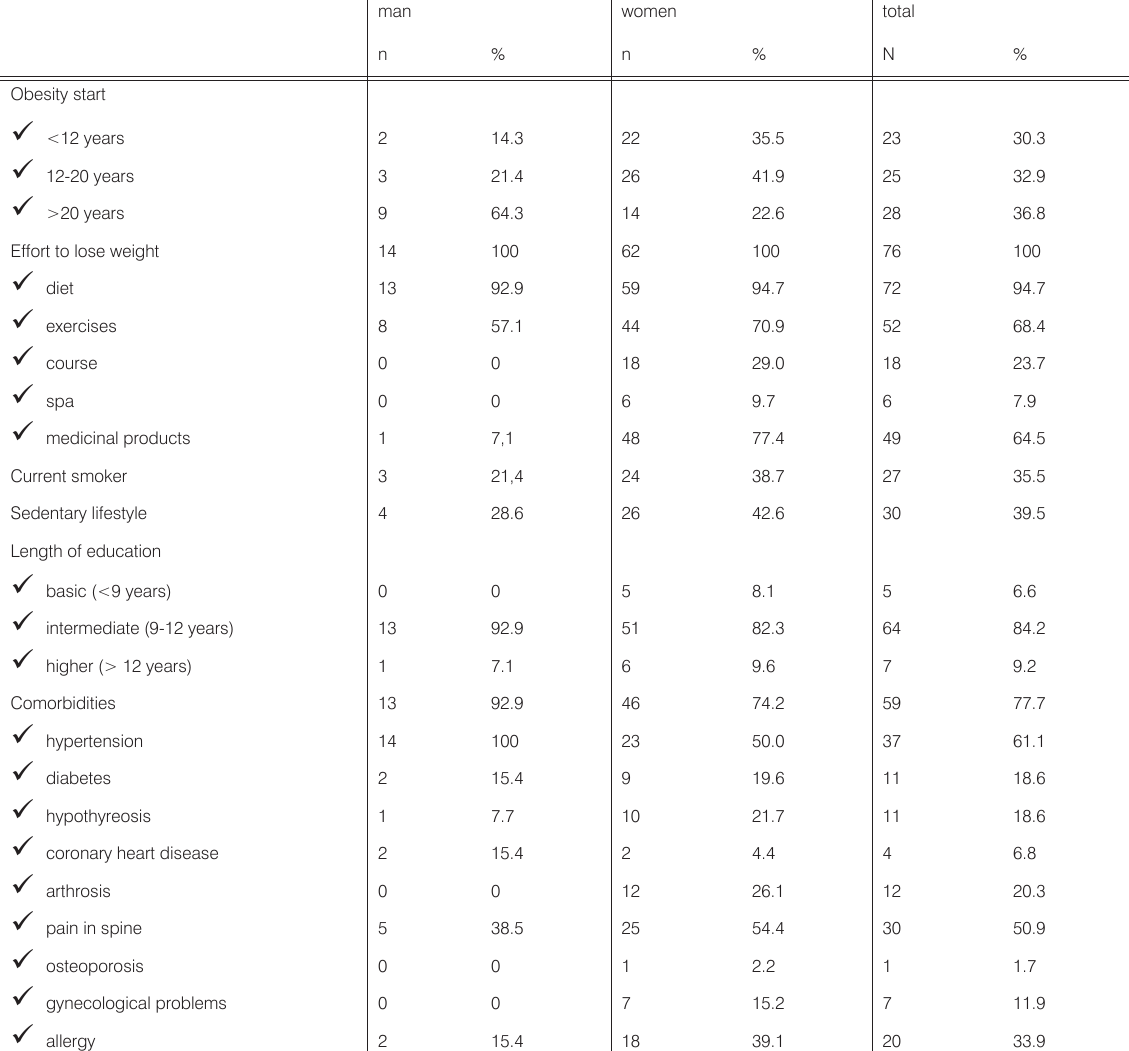
Table 1. Sociodemographic and clinical characteristic of morbidly obese patients